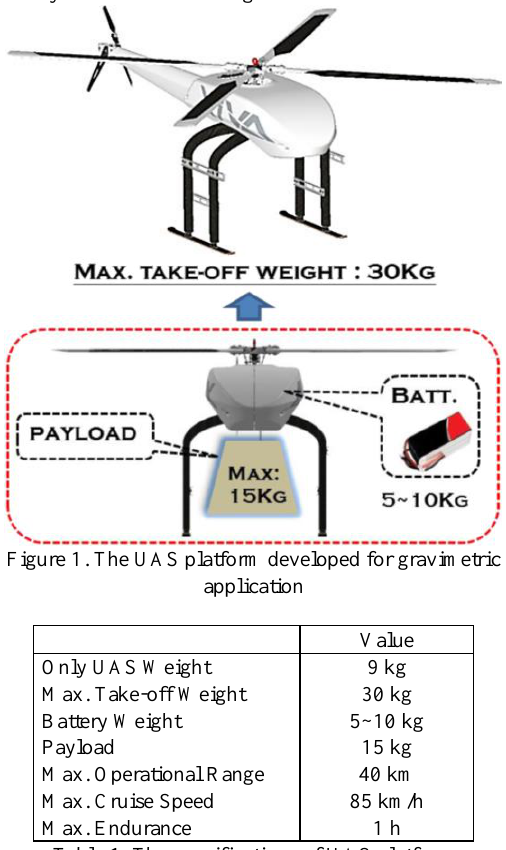
Table 1. The specifications of UAS platform